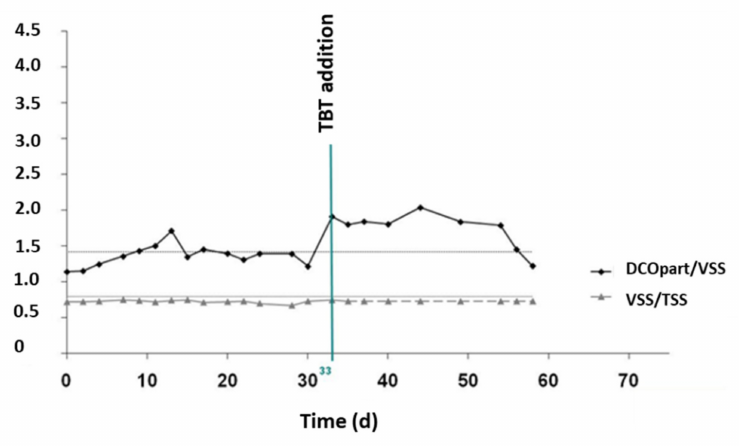
Figure 7. Evolution of VSS/TSS and CODpart/VSS ratios in MBRi system. The VSS/TSS ratio was constant and close to 0.8; the organic content of the sludge did not seem to be modified by the addition of TBT.